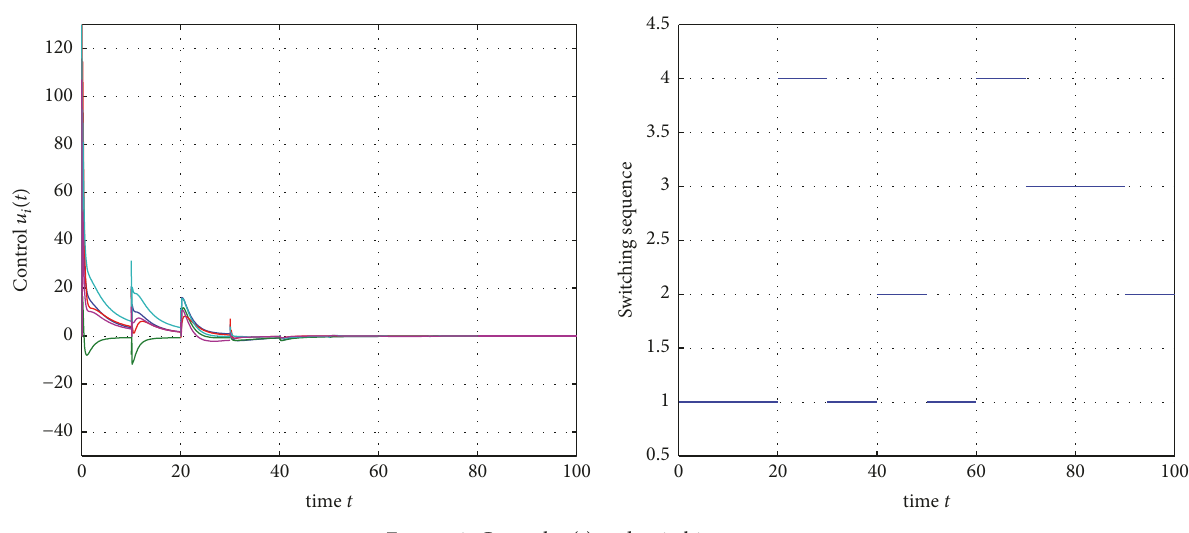
Figure 2: Control 𝑢 𝑖 (𝑡) and switching